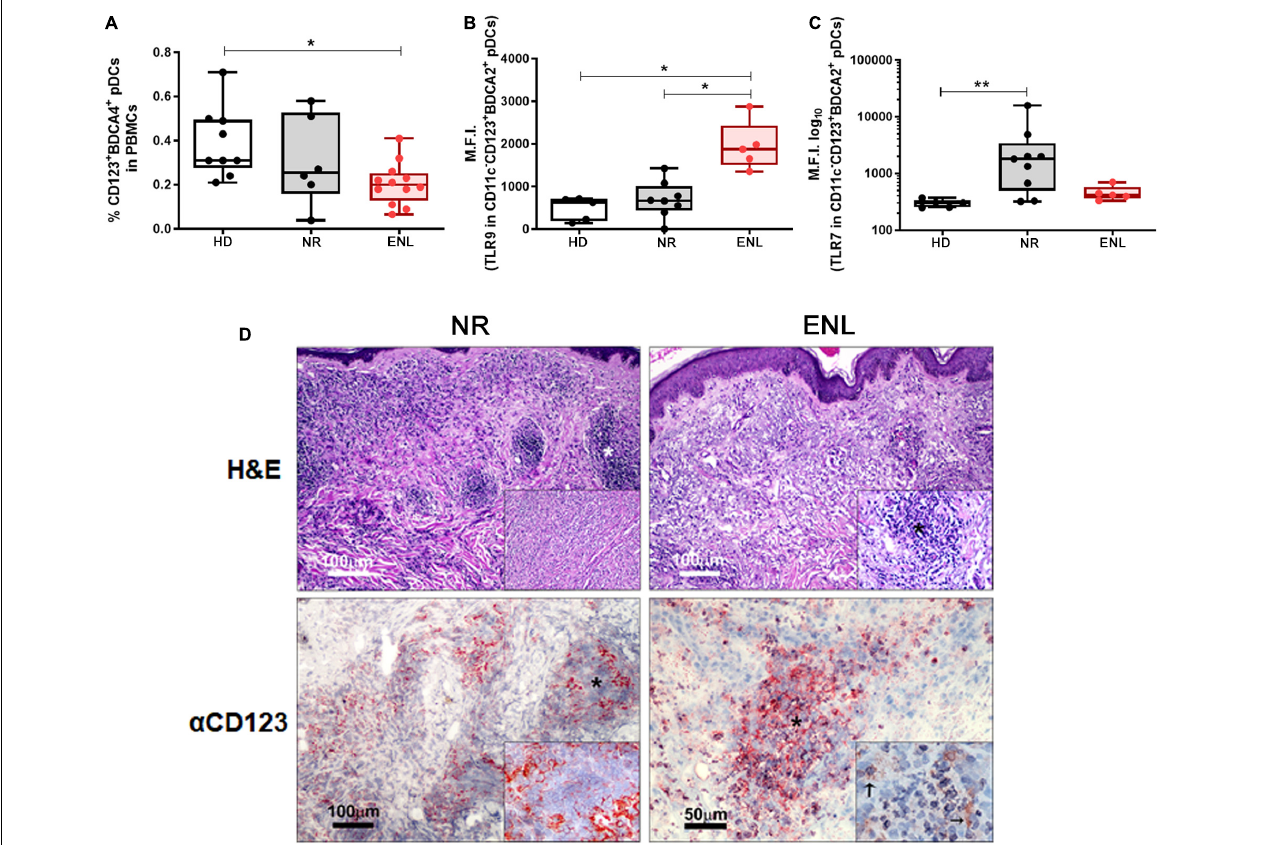
FIGURE 5 | Involvement of plasmacytoid dendritic cells in ENL. (A–C) pDC analysis by flow cytometry. (A) Frequency of Lin - CD11c - CD123 + BDCA4 + pDCs among PBMCs isolated from HD ( n = 9), NR ( n = 6), and ENL patients ( n = 12). TLR-9 (B) and TLR-7 (C) expression levels in pDCs (CD11c - CD123 + BDCA2 + ) present in PBMCs isolated from HD ( n = 5), NR ( n = 8), and ENL patients ( n = 5). Box plots show median, interquartile range, and sample minimum and maximum. Each dot represents a donor. * p < 0.05, ** p < 0.01. (D , Top ) H&E staining of skin lesions from NR and ENL patients. Asterisks indicate inflammatory infiltrates in the dermis. Insets show dermal inflammatory infiltrate with macrophages and rare polymorphonuclear cells (NR) and a microabscess with a high concentration of polymorphonuclear cells (ENL). (D , Bottom ) CD123 immunohistochemical expression in skin lesions of NR and ENL patients. CD123 expression is mainly observed in the peripheral regions of the dermal inflammatory infiltrates (NR), while microabscesses in ENL lesions show a marked expression of CD123. Inset shows expression of CD123 close to neutrophils ( arrows ). Images are representative of three NR and three ENL